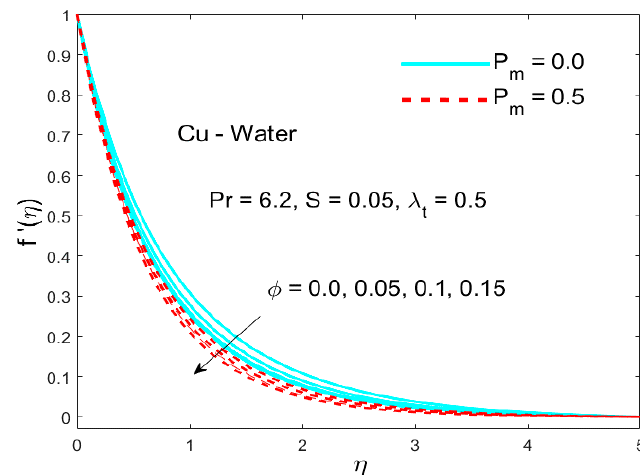
φ Figure 9. Effect of on the axial velocity. φ Figure 9. E ff ect of φ on the axial velocity. Figure 9. Effect of on the axial velocity.